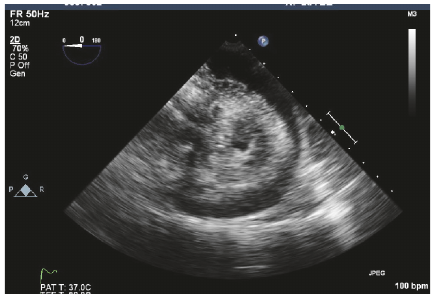
Figure 2: Echocardiography with pericardial effusion.